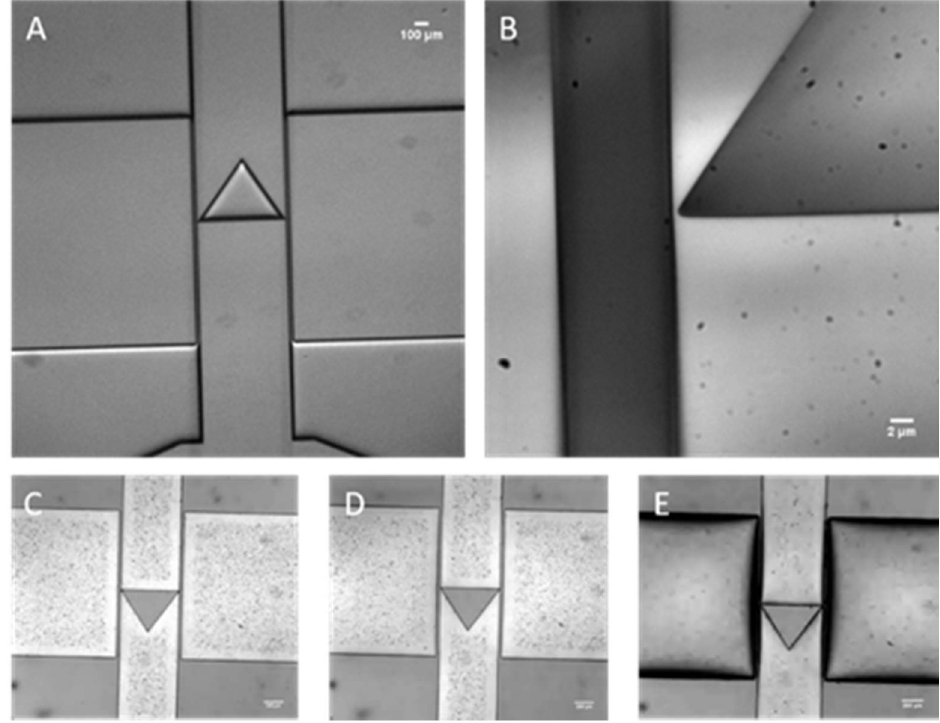
Figure 5. Brightfield images of silicon micromachined mold ( A , B ) and PDMS single layer valve under different actuation pressures ( C , D ). ( A ) Brightfield image of micromachined silicon stamp for soft